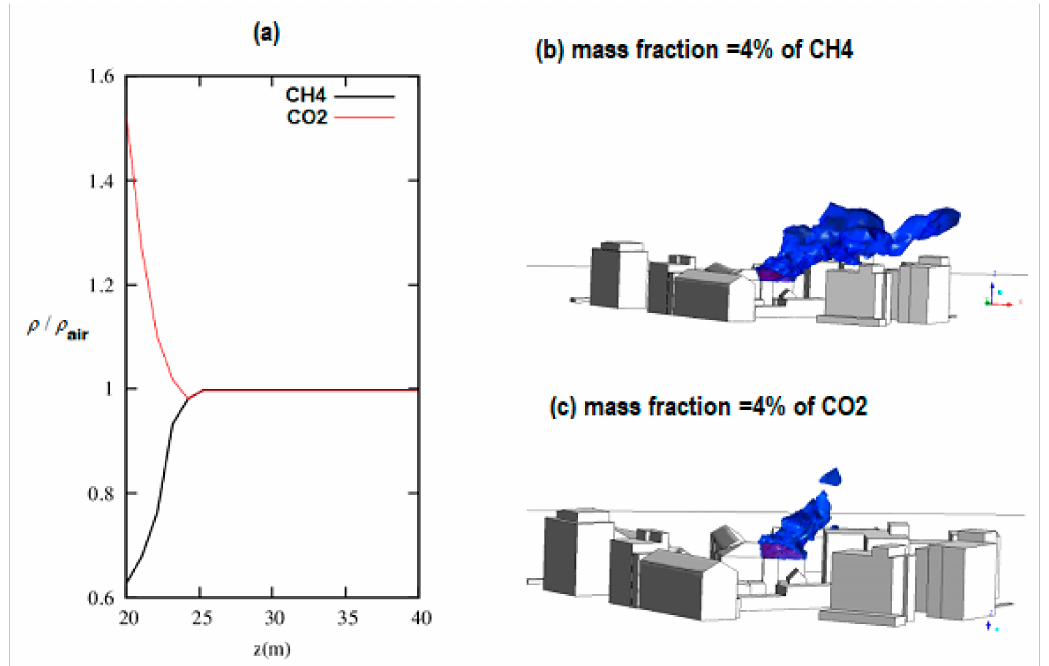
Figure 10. ( a ) Density ratio ρ CO 2 / ρ air , ρ CH 4 / ρ air distribution at the vertical line (x = 0 m, y = 0 m) as a function of the height z, ( b ) iso-surface, representing the plume of CH 4 , ( c ) iso-surface representing the plume of CO 2